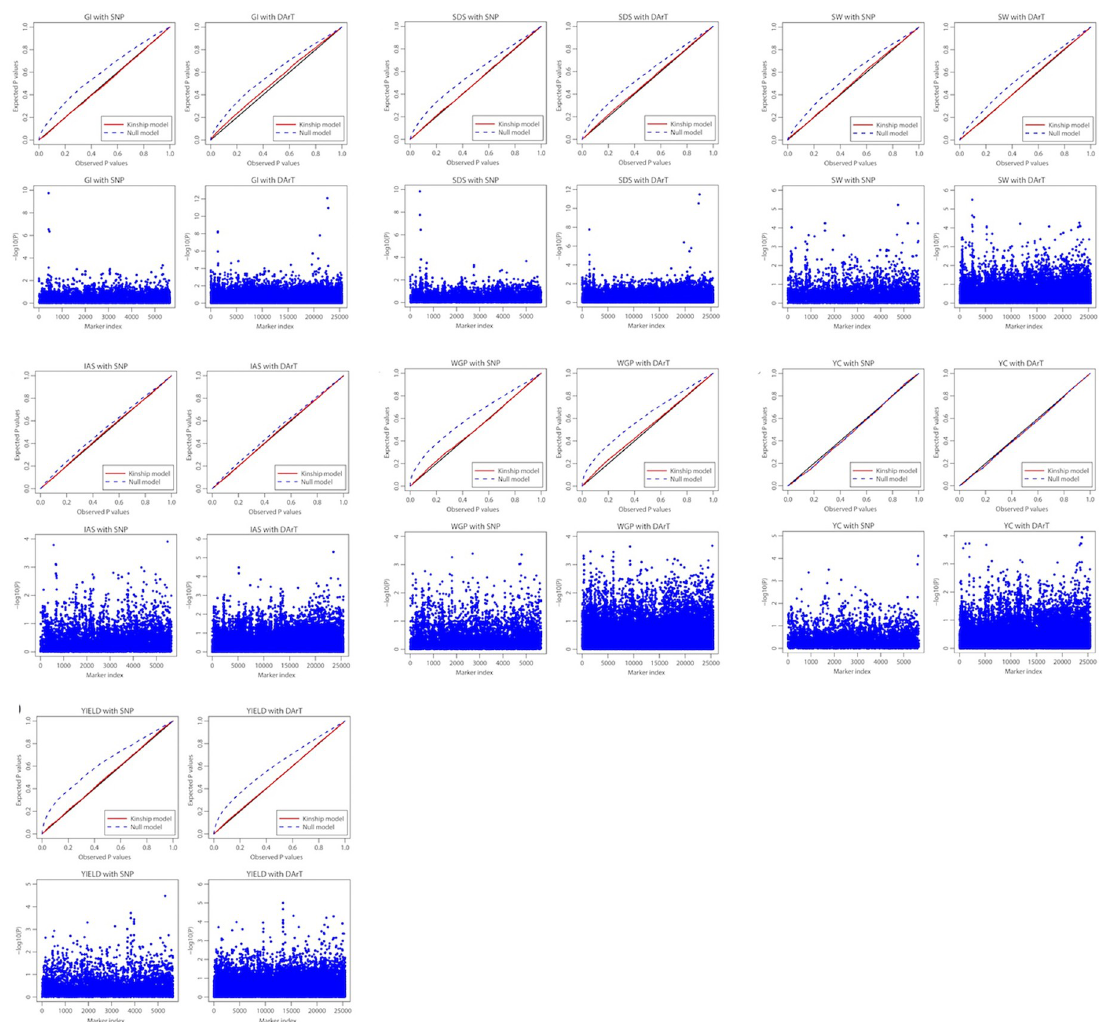
Fig 4. Quantile-quantile plots for the GWAS model and Manhattan plots for the assessed traits. (GI: gluten index; SDS: sedimentation index; SW: specific weight; IAS: initial agronomic score; WGP: whole grain protein; YC; yellow colour; and YIELD: grain yield). Expected and observed P values are shown on QQ-plots. Dotted blue lines represent the null model; red lines show the kinship model. Manhattan plots illustrate the marker index for each trait and the significance of the association test (as the negative logarithm of the P